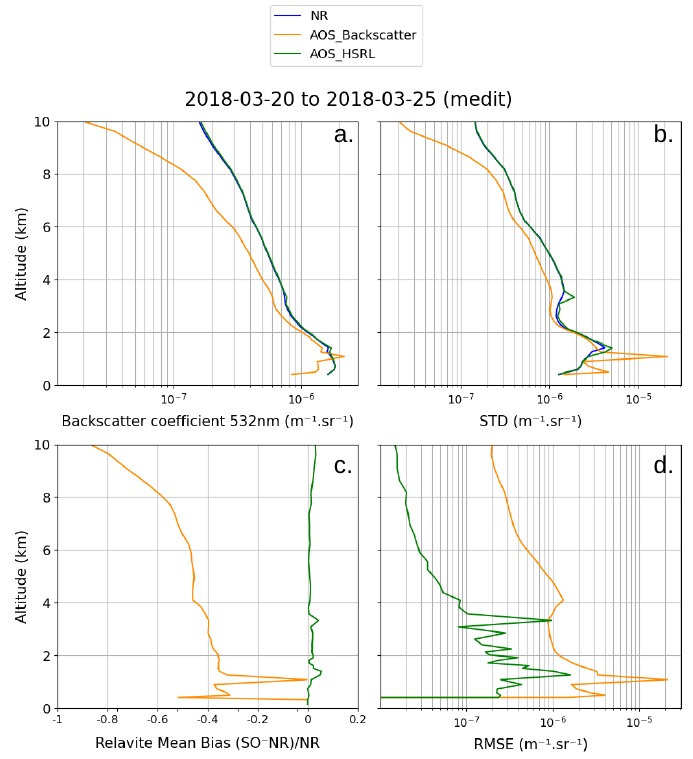
Figure 10. ( a ) Average profiles of particular backscatter coefficients at 532 nm from the NR (blue), the AOS_Backscatter SO (orange), and the AOS_HSRL SO (green) from 20 March to 25 March 2018 over the Medit region. ( b ) Corresponding standard deviation profiles. ( c ) Relative mean biases (SO-NR)/NR of both instruments. ( d ) RMSEs of both instruments versus the